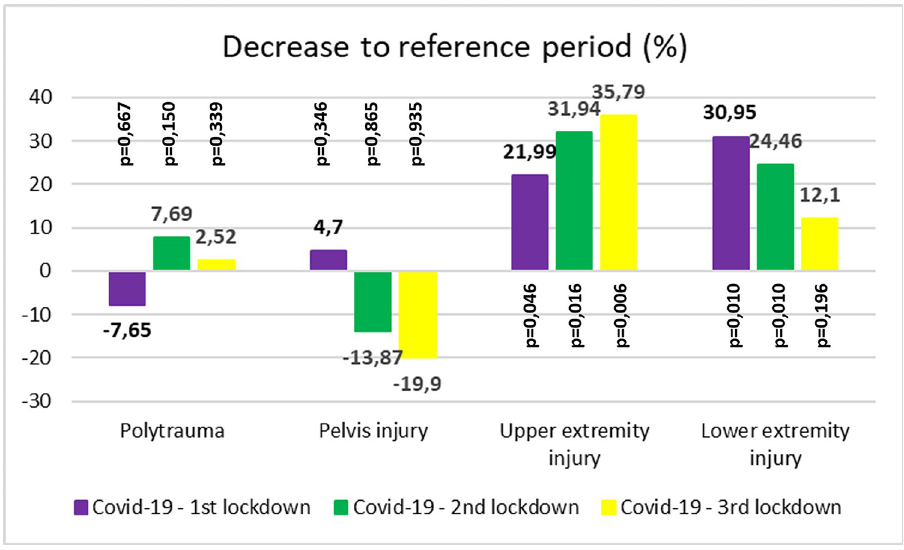
Fig 6. Decrease of injuries. Percentage decrease (y-axis) in the number of individual injuries in lockdown periods relative to the reference period. The p value indicates the statistical significance of the decrease. Negative values indicate an increase in the number of inpatients. The p value indicates the statistical significance of the